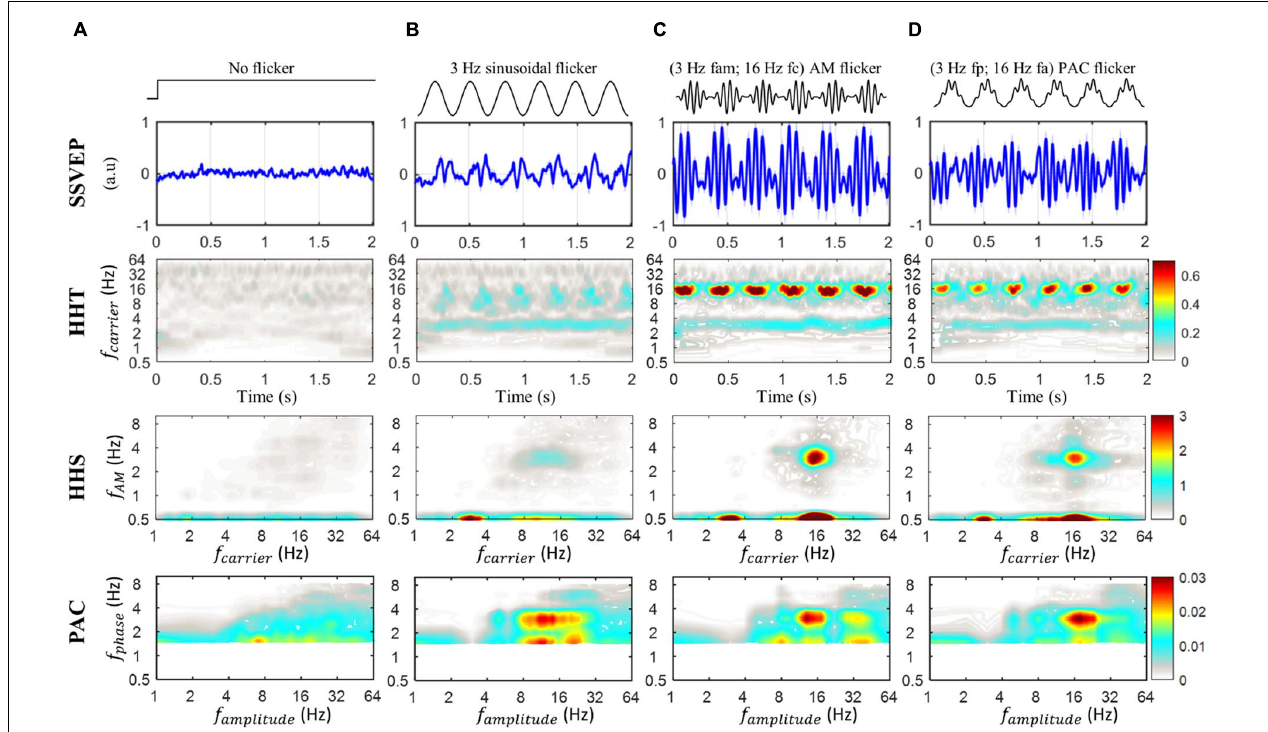
FIGURE 7 | The SSVEP response induced by stimulus with no flicker (baseline), sinusoidal flicker, AM flicker and phase-amplitude coupling flicker, averaged for each condition across subjects for Oz channel recordings. (A) The SSVEP response induced by stimulus with no flicker, which was presented at a mean luminance. The amplitude density of the HHT spectrum is unclear. The HHS and comodulogram of the baseline condition (i.e., no flicker condition) also show an unclear pattern of amplitude response. (B) The SSVEP response induced by stimulus with 3 Hz sinusoidal flicker. The HHT shows an amplitude increase at the stimulus frequency (i.e. 3Hz) and the higher frequencies (alpha/beta band). In addition, the SSVEP amplitude at higher frequency are modulated by the frequency of the stimulus (3 Hz). In the HHS, the SSVEP amplitudes of stimulus frequency (3 Hz) and 3 Hz AM residing in alpha/beta oscillations are observed. The coupling increase between 3 Hz phase and alpha/beta amplitude can be seen in the comodulogram. (C) The SSVEP response induced by amplitude-modulated flicker, which was a 16 Hz carrier and its 3 Hz amplitude modulation. The SSVEP spectrum observed with HHT shows the amplitude increase at 3 Hz and at 16 Hz with its amplitude modulation. The HHS shows the peak amplitudes increase at the 16 Hz carrier frequency ( x -axis) and its 3 Hz AM ( y -axis), which correspond to the stimulus frequency. In addition, the peak amplitude at 3 Hz slow oscillation as a non-linear component is also observed. The comodulogram reveals the coupling increase at 3 Hz phase and 16 Hz amplitude. A second coupling increase between 3 Hz phase and 32 Hz amplitude is also observed. (D) The SSVEP response induced by phase-amplitude coupling flicker, which was a 16 Hz amplitude frequency nested in a 3 Hz phase. SSVEP spectra observed in HHT show a similar pattern as in panel (C) . The HHS shows the peak amplitude increase at 16 Hz carrier ( x -axis) and its 3 Hz AM ( y -axis), which correspond to the amplitude-modulated oscillation (or modulated oscillation). In addition, the peak amplitude at 3 Hz oscillation also increases corresponding to the 3 Hz phase oscillation. The 3 Hz phase coupled with 16 Hz can be clearly seen in the comodulogram. A color bar displays z-scores of MI values above the 95th percentile of shuffled distributions (z-score >